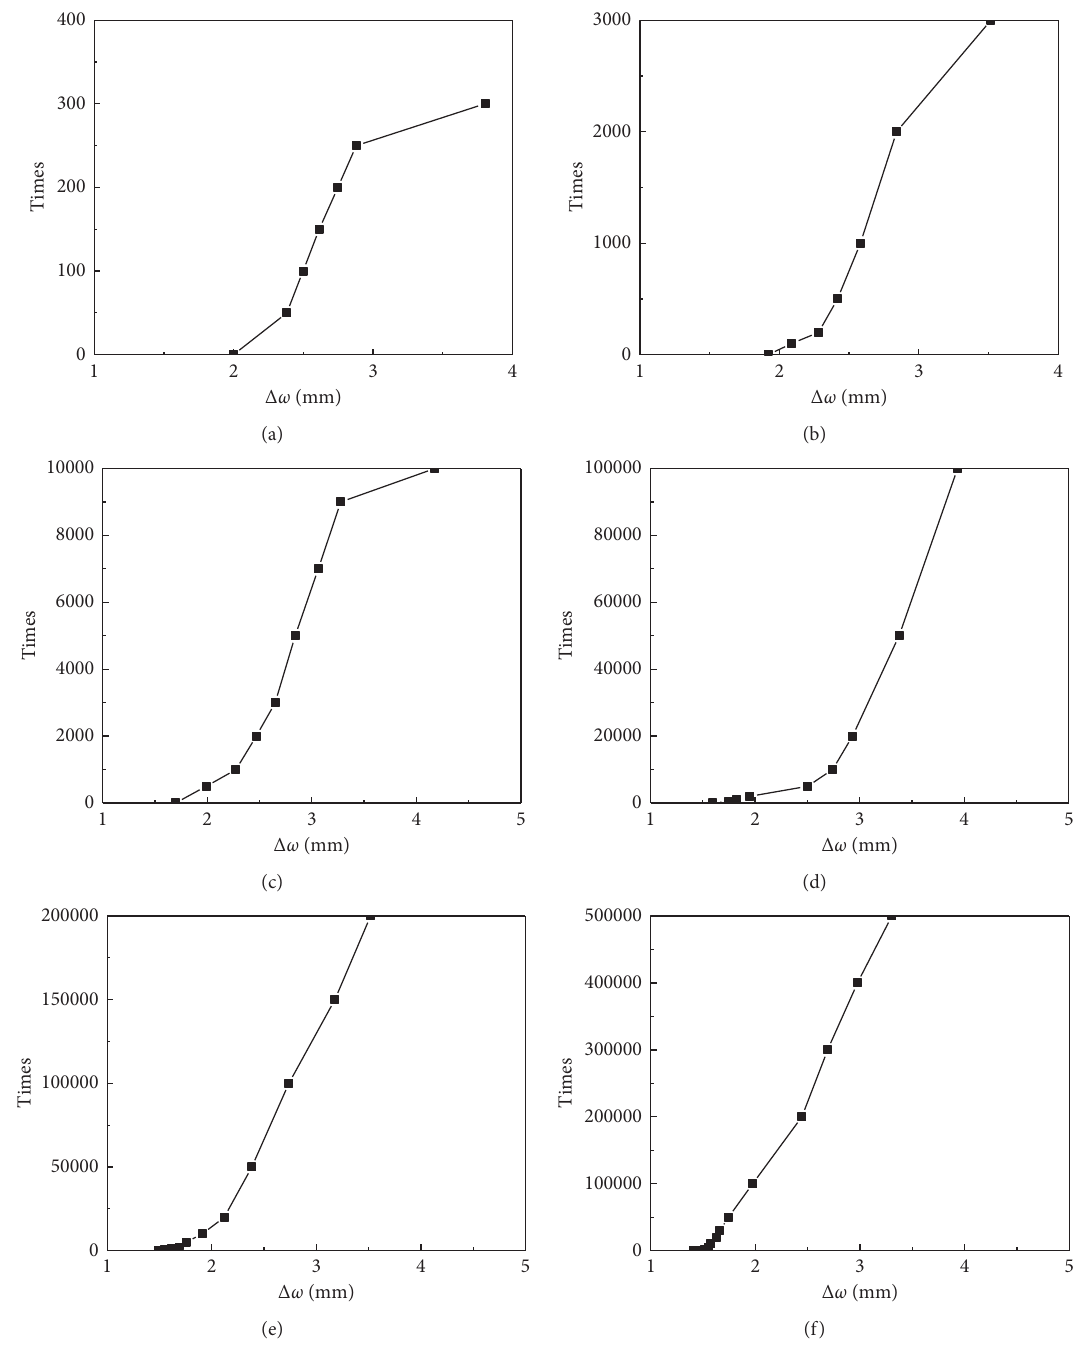
Figure 10: Relative slip curves of BFRP grid-concrete interface as a function of fatigue time. (a) F-1. (b) F-2. (c) F-3. (d) F-4. (e) F-5. (f)